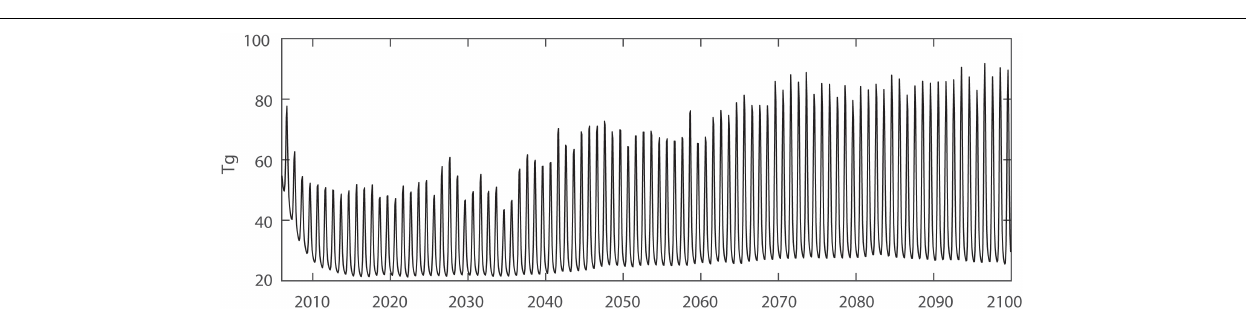
FIGURE 4 | Scenario RCP 8.5. Total amount of simulated organic carbon in the Arctic